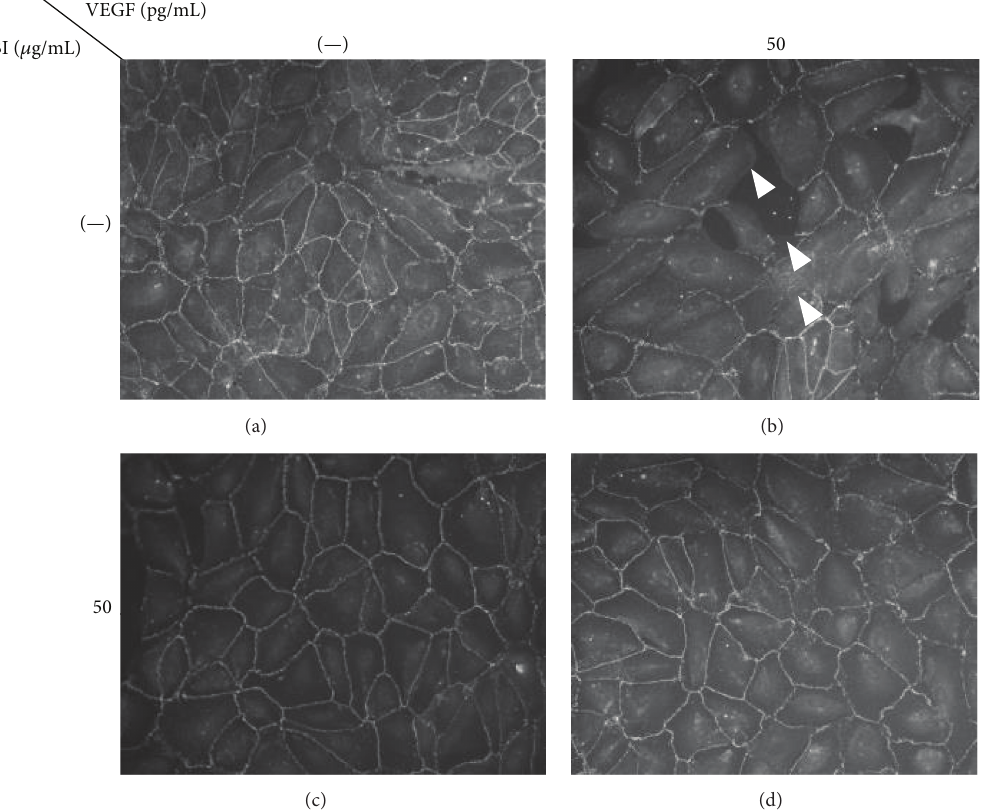
Figure 4: LBI can protect tight junctions from VEGF. Fifty pg/mL of VEGF was added to culture medium for 6 hrs. ARPE-19 cells ((a)– (d)) were stained with anti-ZO-1 antibody and TJs conformation was evaluated. Note that TJs breakdown was observed after VEGF ((b) arrows). LBI pretreatment before VEGF addition could protect TJs from disruption (d). LBI, lecithin-bound iodine; TJs, tight junctions; VEGF; vascular endothelium growth factor; ZO-1, zonular